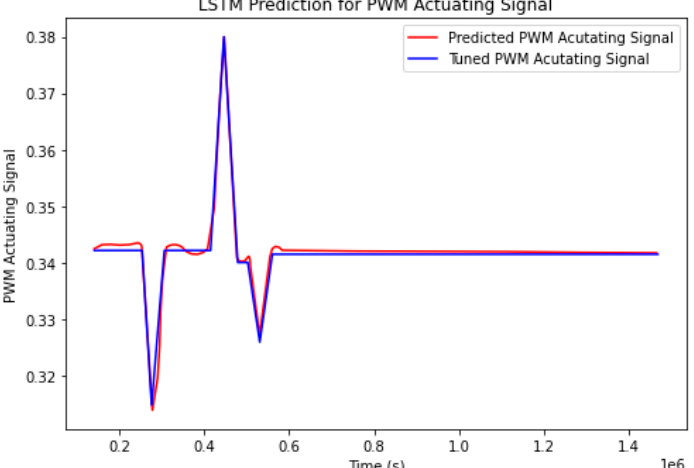
Figure 23. The response of the LSTM actuating signal in comparison with the tuned control meth- odology for the 18th of November.